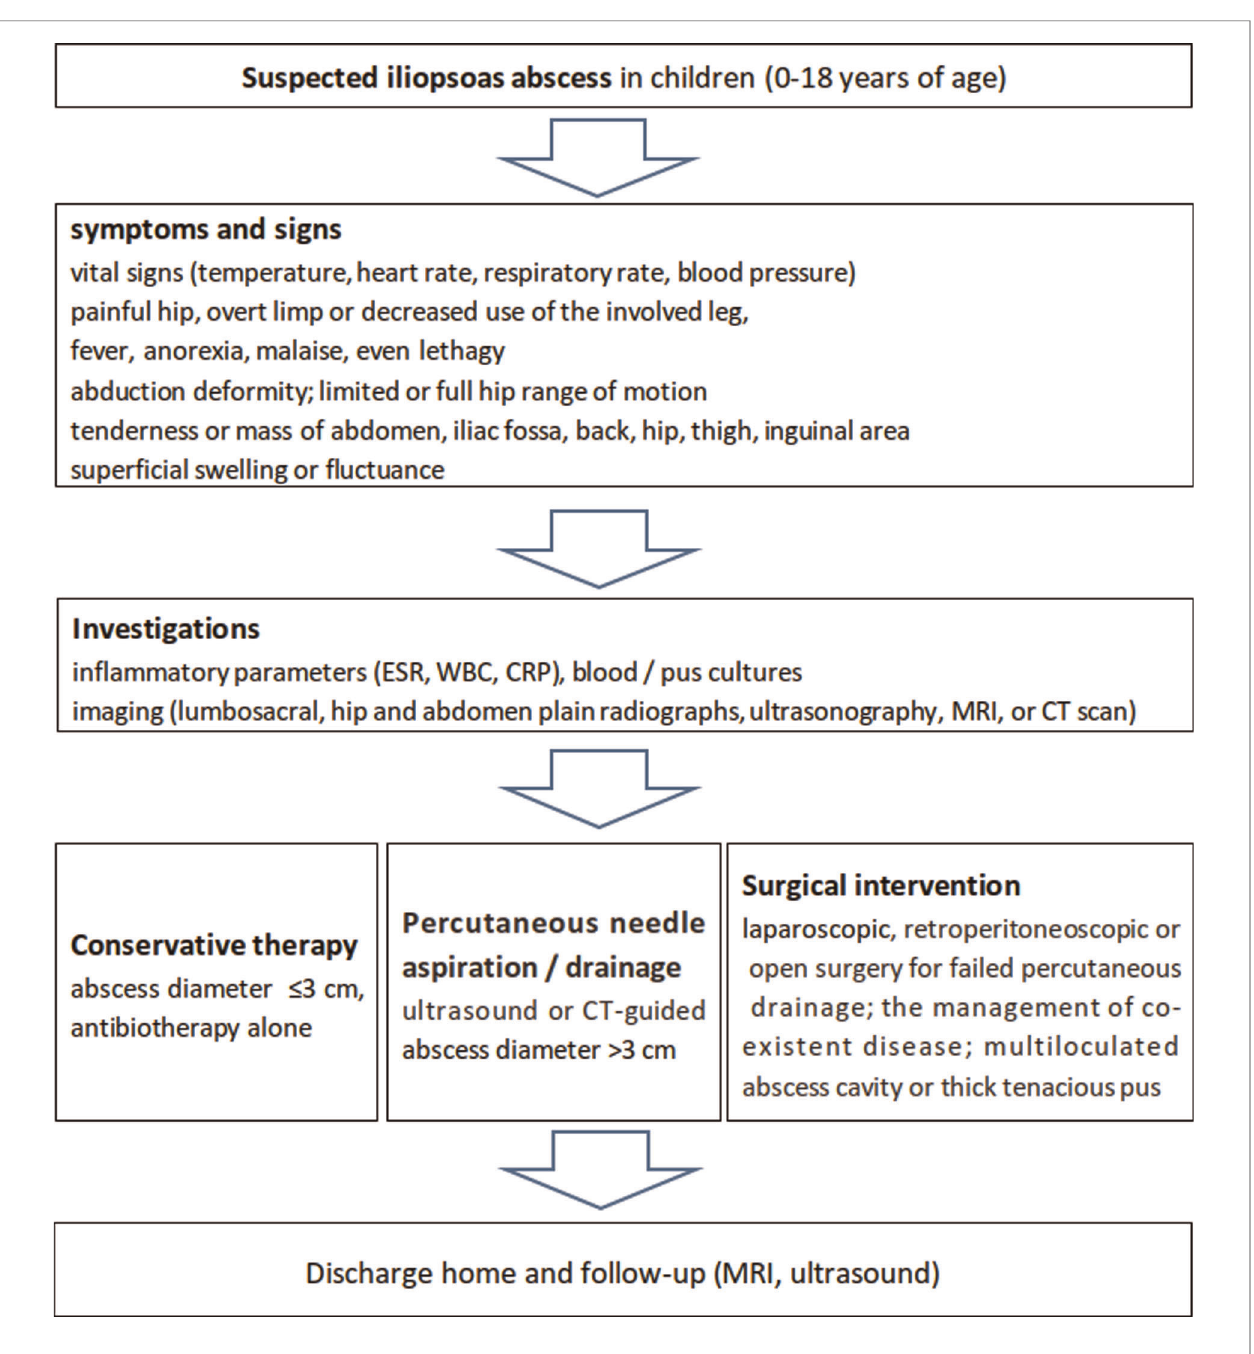
FIGURE 3 | Recommended fl ow chart for the diagnosis and management of iliopsoas abscess in the pediatric population according to the literature and our